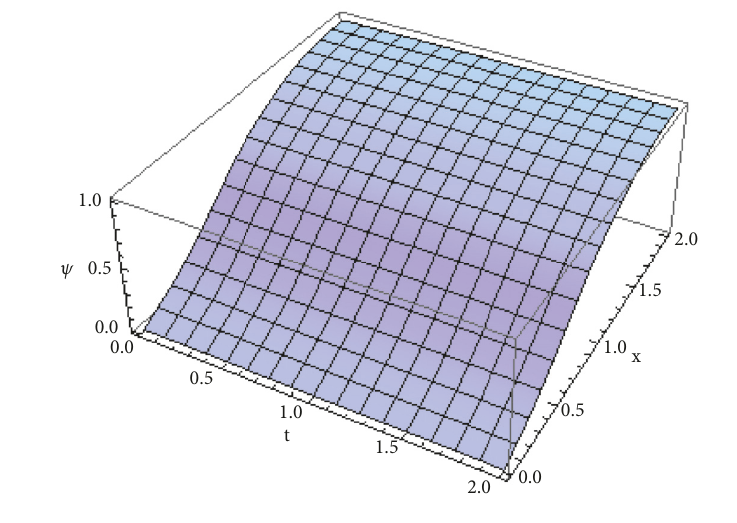
Figure 4: Imaginary solution of the one-dimensional wave function obtained by